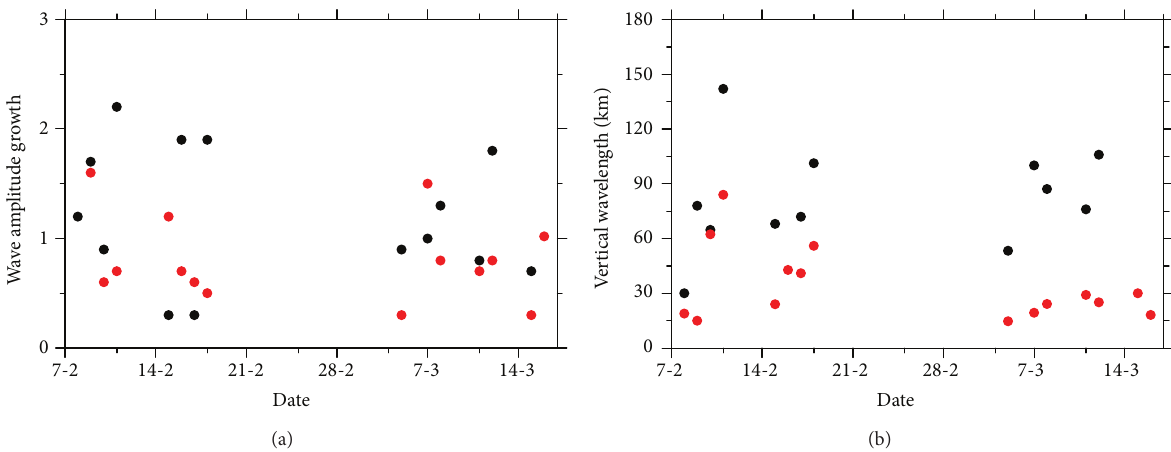
Figure 2: Night-to-night variation in the wave amplitude growth (a) and vertical wavelength (b) of the observed waves during February- March 2010 (plotted in month/day format). Filled black and red circles show the results for principal and residual waves, respectively.